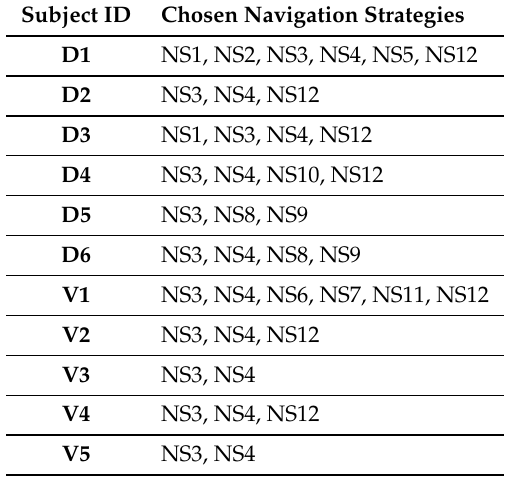
Figure 15. Navigation micro-strategies (NS) of blind and sighted participants. Table 4. Navigation strategies (NS) chosen by each